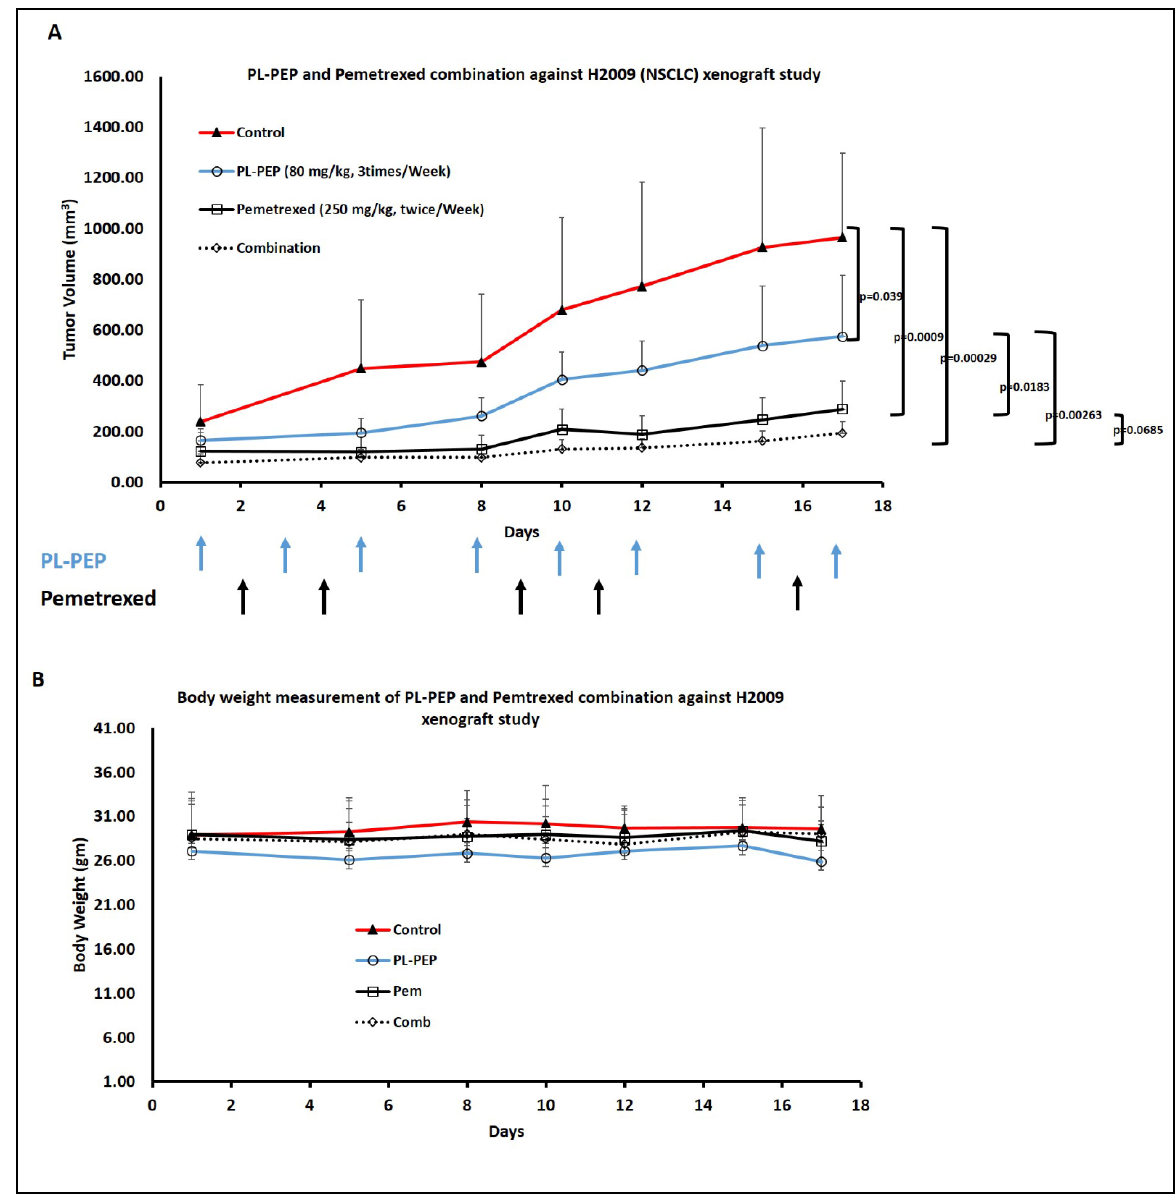
Figure 7. PEGylated Liposomal D-Arg PEP (PL-PEP) in combination with pemetrexed inhibited growth of H2009 NSCLC xenografts in mice. 5 × 10 6 H2009 cells with matrigel (1:1 v / v ratio) were injected subcutaneously in right flank of nude mice. Once the tumor was palpable (around 2 weeks from cell injection), mice were randomized into 4 groups ( n = 5 ). Mice were treated i.p. as follows: control group (saline, twice per week); PL-PEP group (80 mg/kg, 3 times per week); pemetrexed group (250 mg/kg, twice per week); and combination group (PL-PEP at 80mg/kg, 3 times per week and pemetrexed at 250 mg/kg, twice per week). The mice were treated with either a single or combination of drugs for around 3 weeks. Each drug treatment is shown by arrows. Tumor size and body weight were measured twice a week. Tumor volume ( A ) was measured using (L) (W) 2 /2. The combination of PL-PEP and pemetrexed treatment showed no change in body weight through the course of the experiment ( B ). Data were plotted and SEM was calculated. P -values < 0.05 were considered significant.